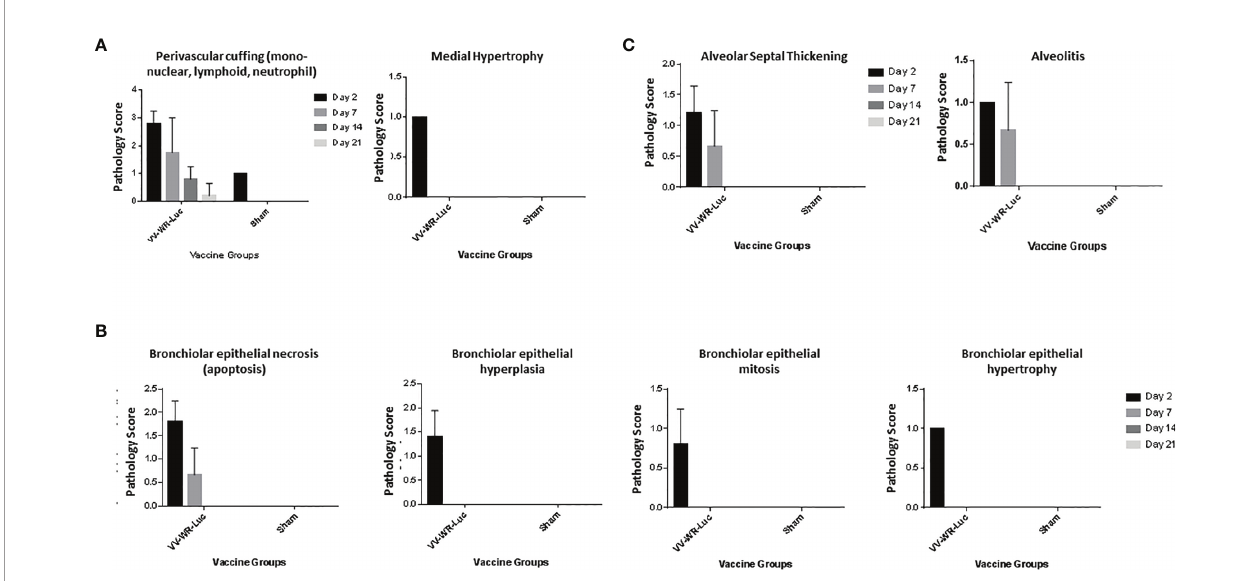
FIGURE 2 | Intranasal administration of VV-WR-Luc causes transient and mild pathology in the lungs. Balb/c mice were intranasally administered 10 6 PFU of the VV-WR-Luc construct or sham and necropsied at day 2, day 7, day, 14, and day 21 with n = 5 mice per time point per group. The left lobe of the lung was evaluated for histopathological changes. The Pathological scoring of the vasculature (A) , bronchiolar (B) , and alveolar (C) compartments of the lungs are shown.